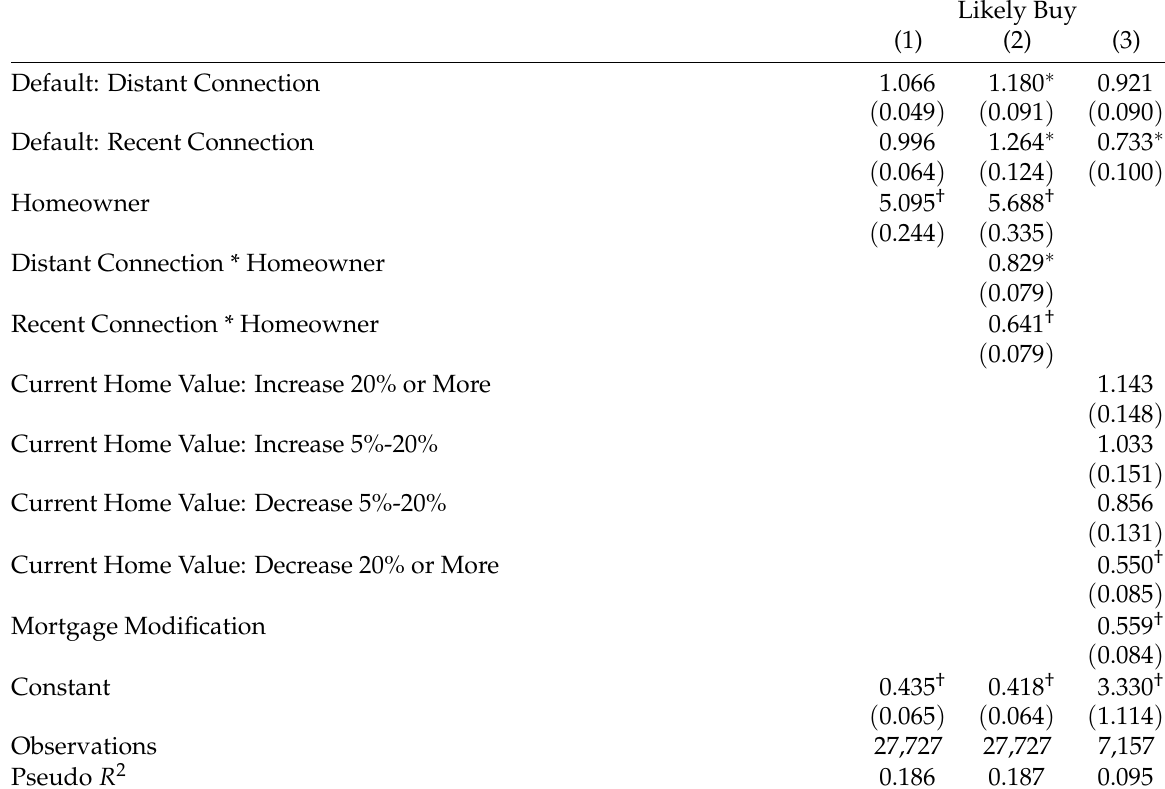
Table 4: Odds ratios from logistic regression of expected homeownership